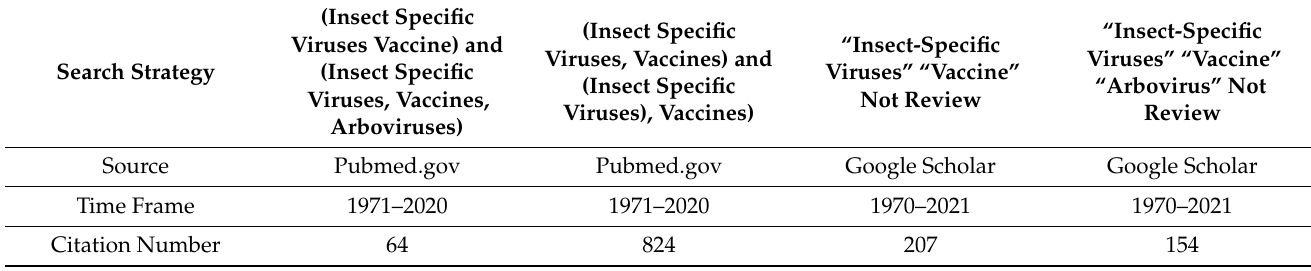
Table 2. Summary of the search strategy, sources employed, timeframe and citation